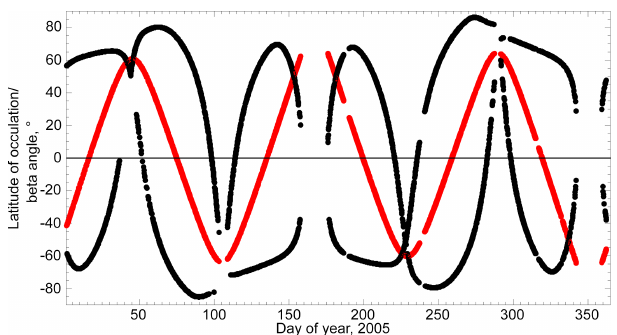
Figure 3. The ACE-FTS sampling pattern for the year 2005. Each black circle is the latitude of the 30km tangent height of an oc- cultation and each red circle is the corresponding beta angle of the